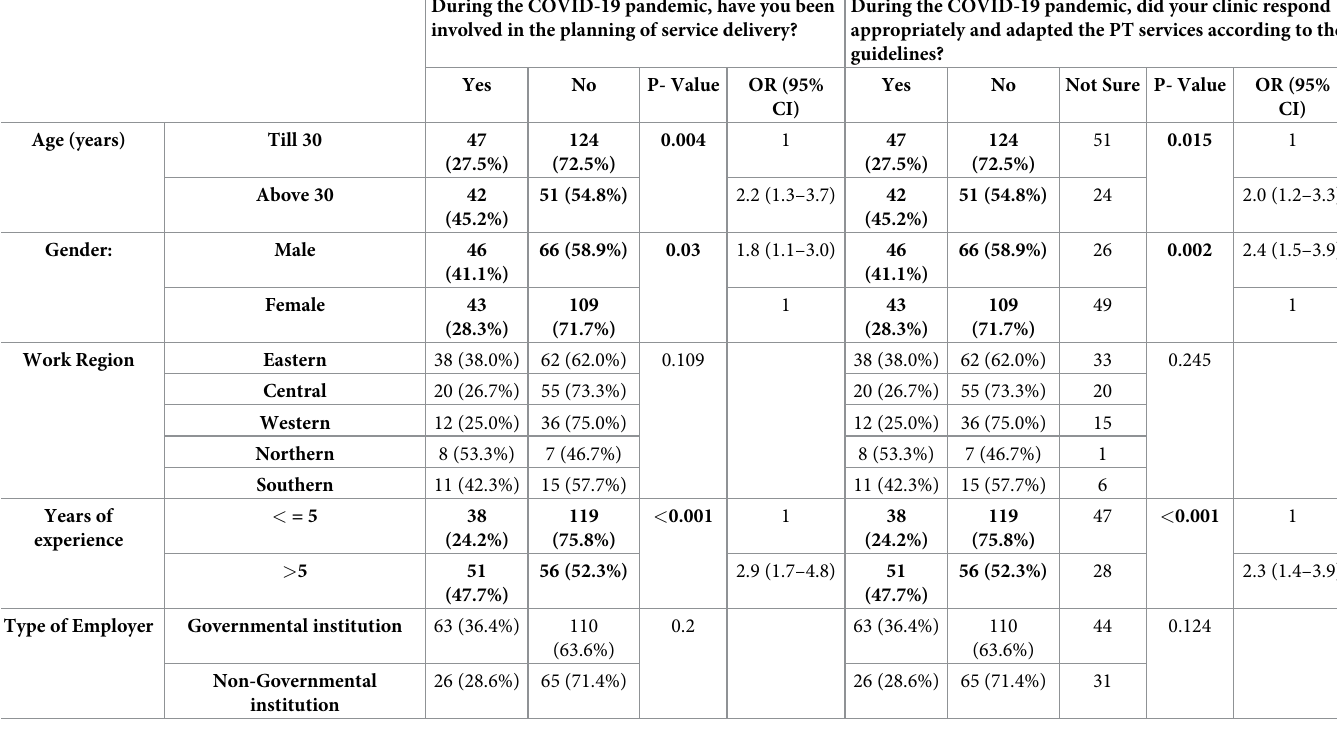
Table 3. Involvement of physiotherapists in service planning and their clinic